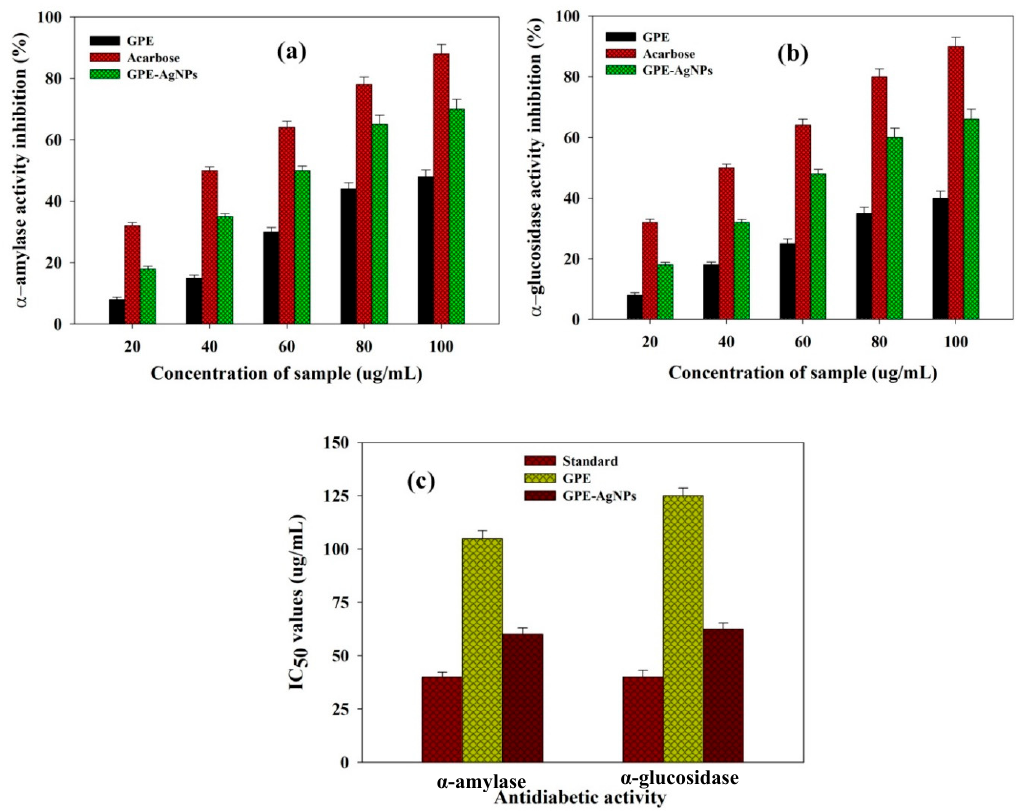
Figure 5. Inhibitory percentage of ( a ) α -amylase and ( b ) α -glucosidase enzyme activity by GPE, standard acarbose, and biosynthesized GPE-AgNPs at various concentration and their ( c ) IC50